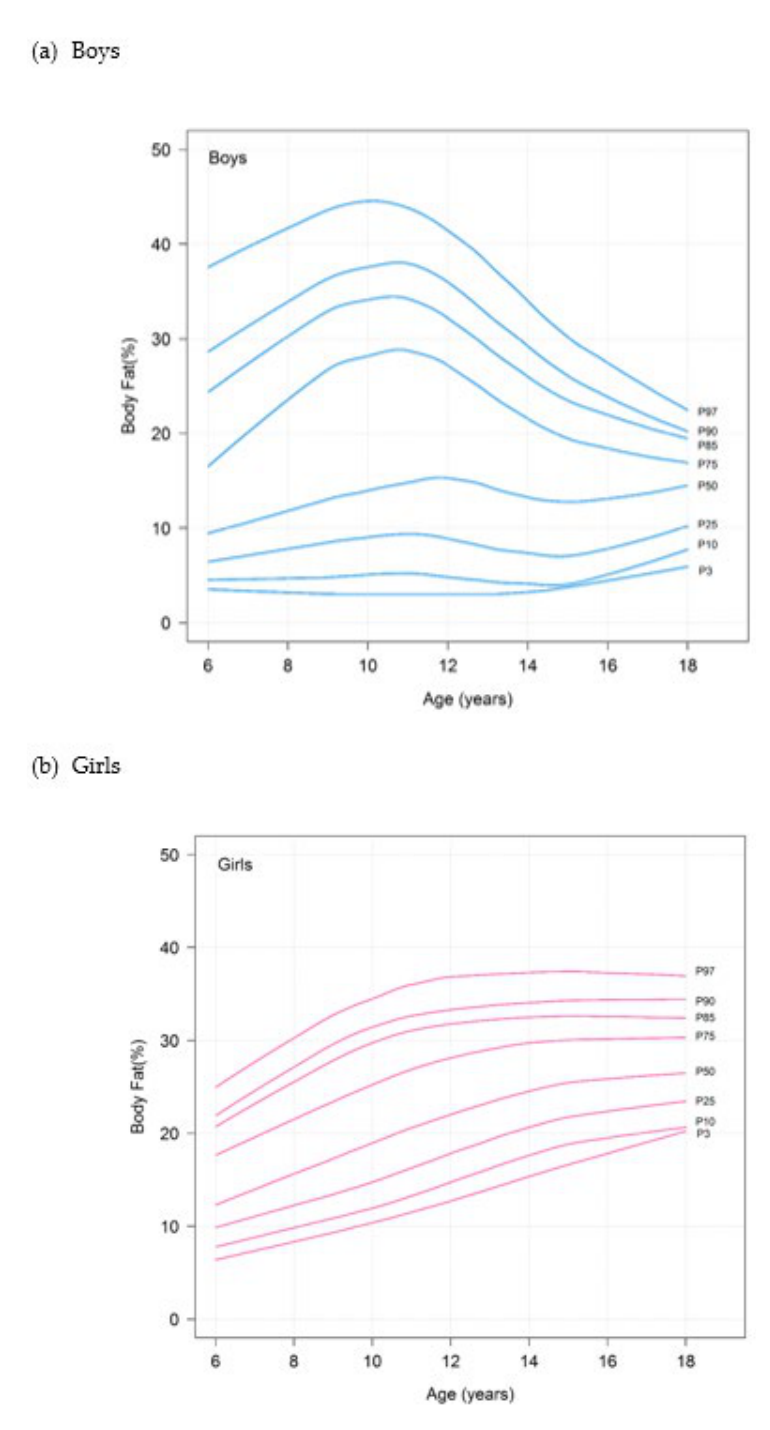
Figure 2. Percentile curves for percentage body fat of ( a ) boys and ( b ) girls.